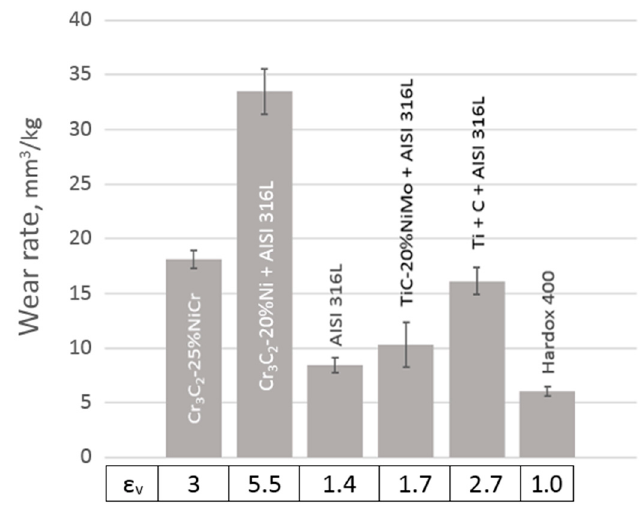
Figure 10. Wear rates and relative volumetric wear resistance ( ε ν ) to the Hardox 400 steel of HVOF sprayed coatings at AEW.